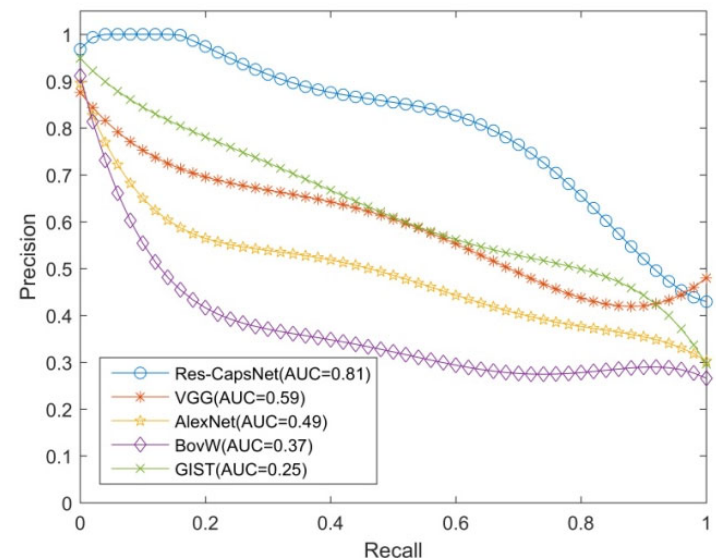
Figure 10. Precision–recall curves of the day ‐ right vs. night ‐ right datasets.